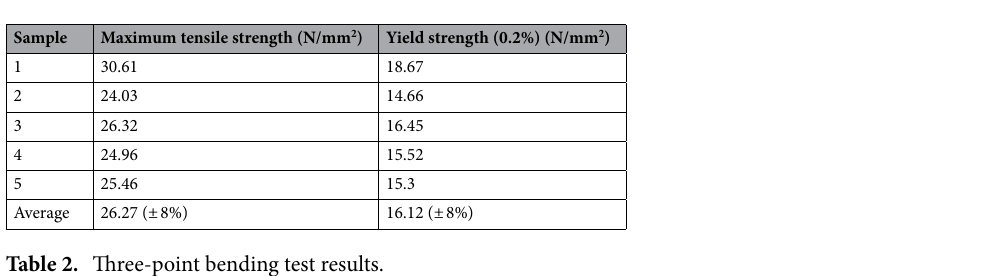
Table 2. Three-point bending test results.